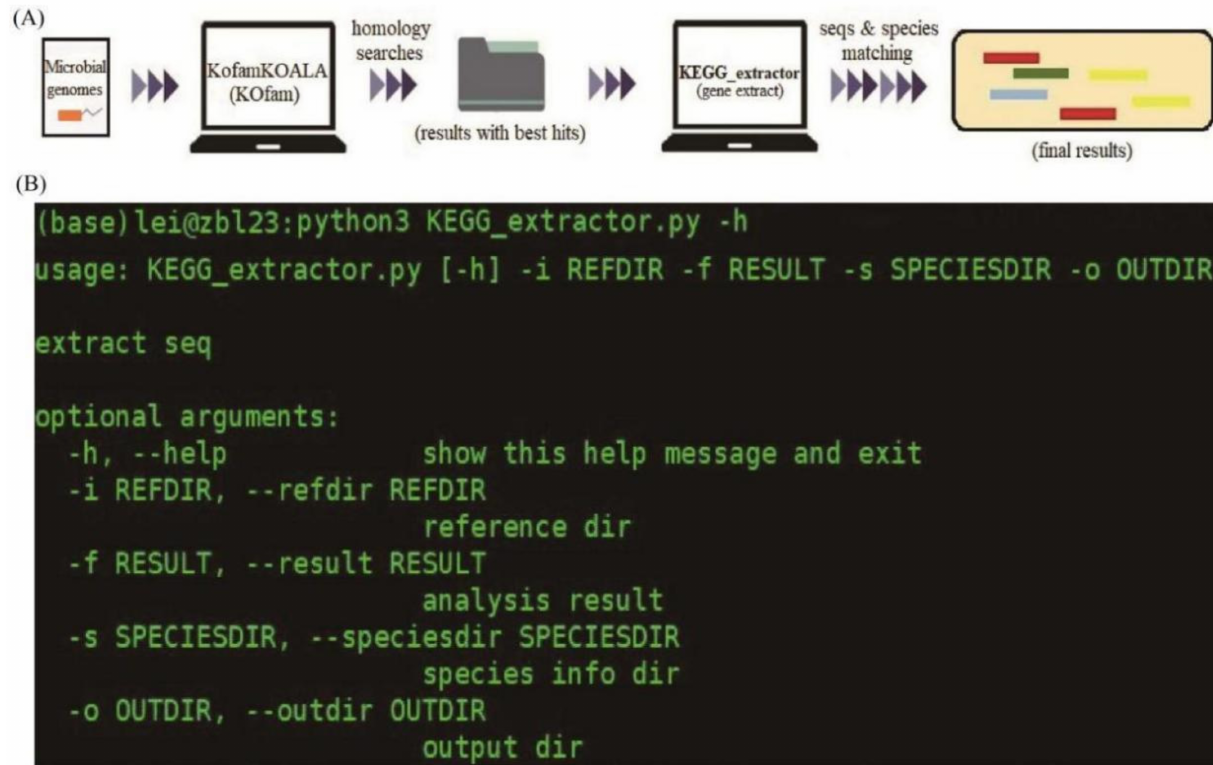
Figure 1. Workflow ( A ) and parameter ( B ) of the KEGG_Extractor